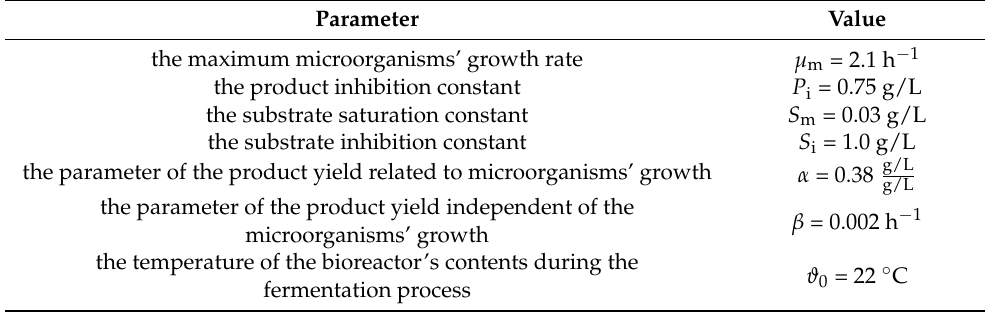
Table 2. Parameters of the Mathematical Model for the Fermentation Process in the Studied Bioreactor.